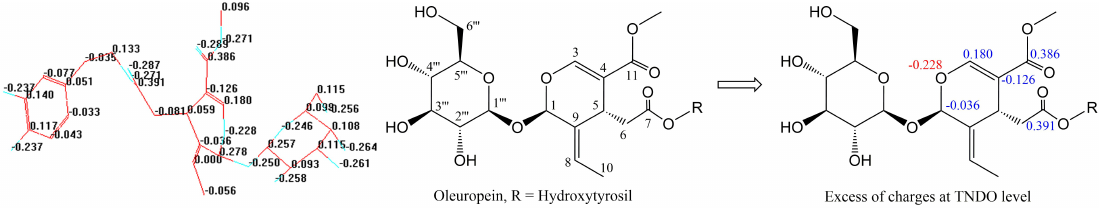
Figure 5. Oleuropein excess of charge on C7, δ = 0.391; C11, δ = 0.386; C4, δ = −0.126; C3, δ = 0.180; O2, δ = −0.212; C1, δ = −0.036 .